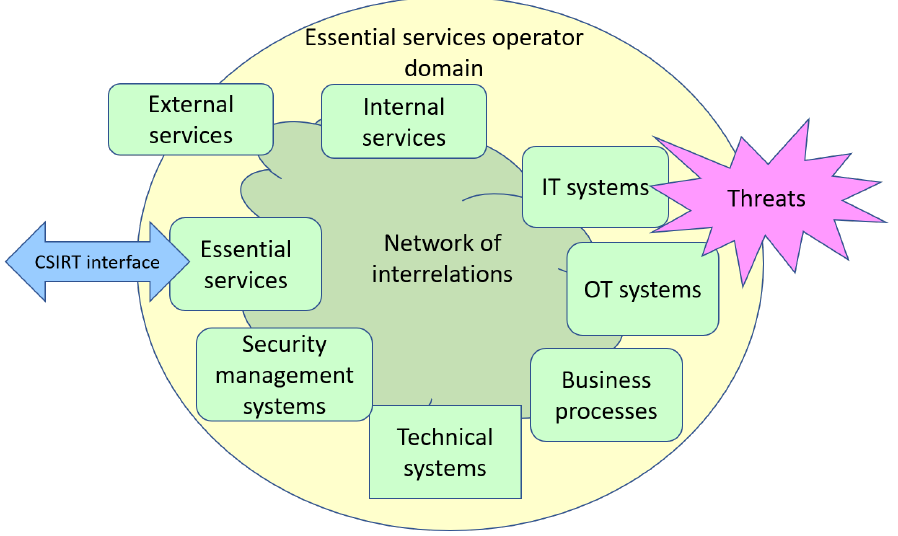
Figure 1. Cyberspace of an essential services